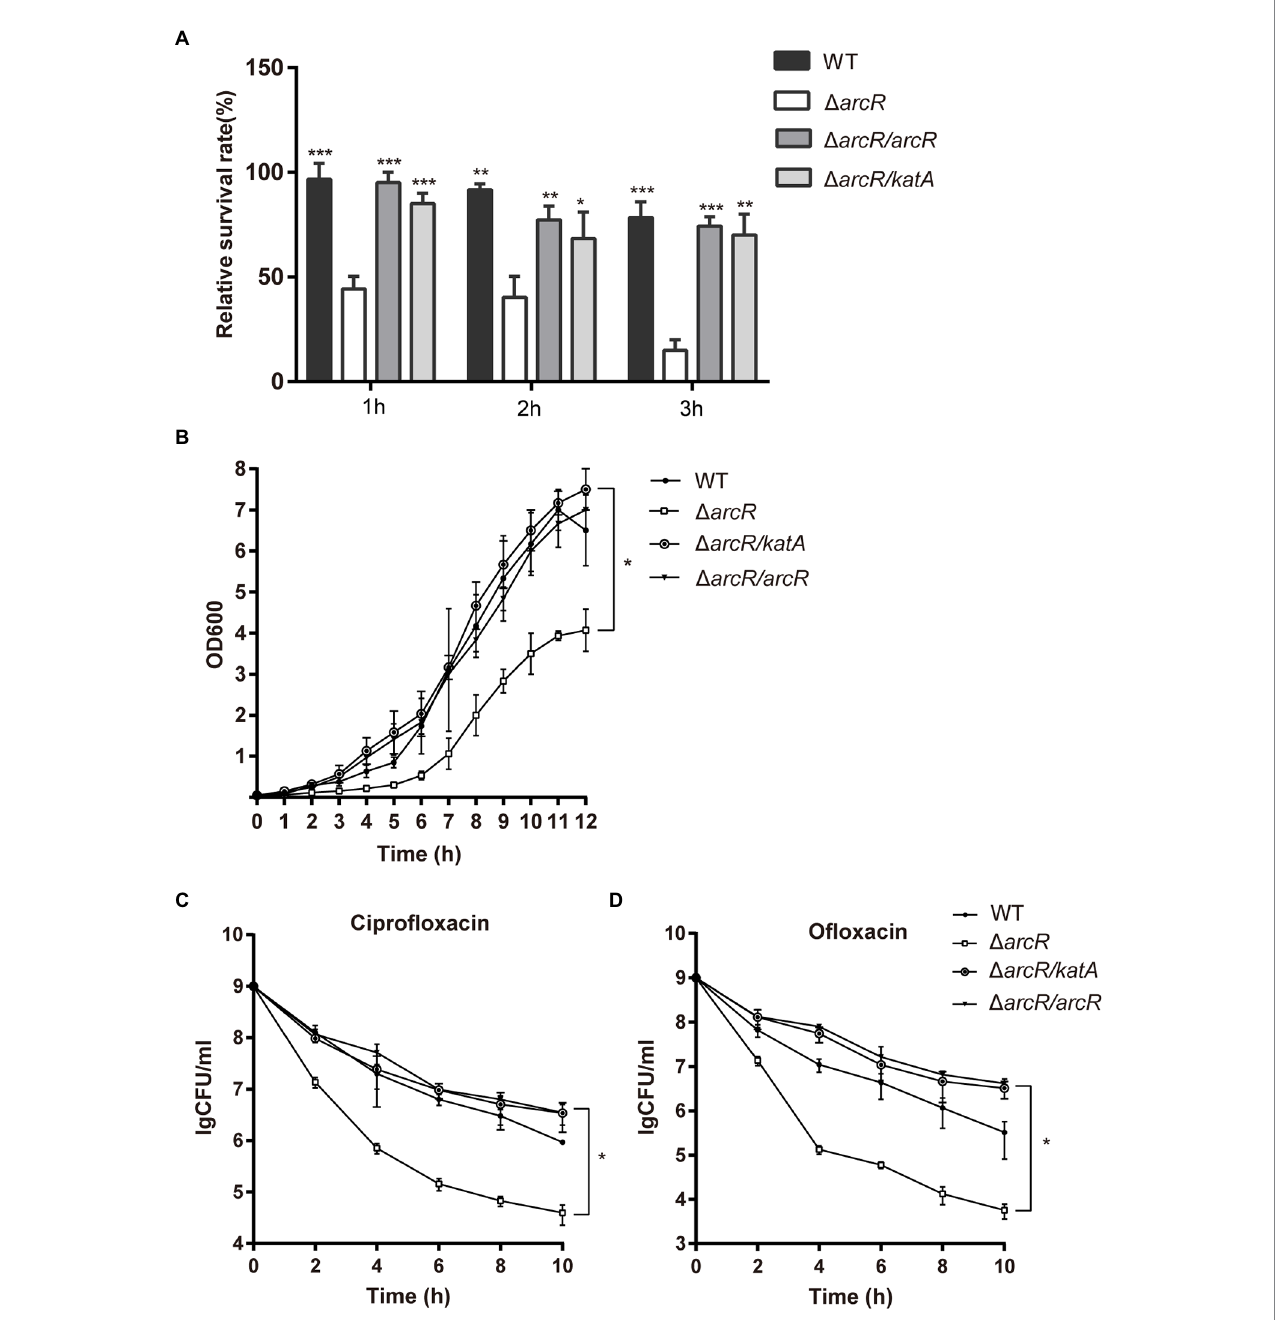
FIGURE 5 Overexpression of katA restored resistance of Δ arcR mutant against antibiotics and oxidative stress. (A) Bacteria were incubated with mouse neutrophils at MOI 5 in HBSS for 3 h. (B) Bacteria were treated with 0.4 mM H 2 O 2 for 12 h in TSB at 37 ° C. (C and D) Bacteria were treated with (C) 0.32 μ g/ml ciprofloxacin or (D) 0.5 μ g/ml ofloxacin for 10 h in TSB with agitation. Live counts were determined by plating. Δ arcR / katA represented the katA overexpression strain, pCN51- katA in Δ arcR mutant. The data represent results from three independent experiments. ns, not significant. * p < 0.05, ** p < 0.01, and *** p < 0.001, by Student’s t